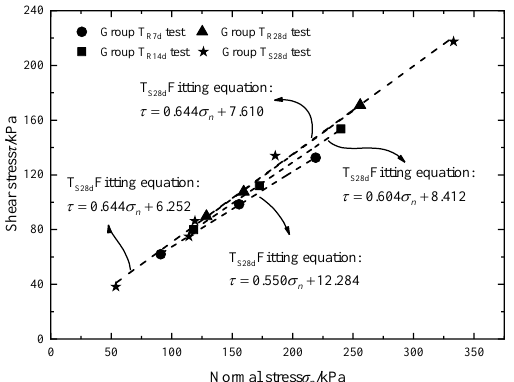
Figure 16. Fitting curve of repeated loading and unloading of variable normal stress.